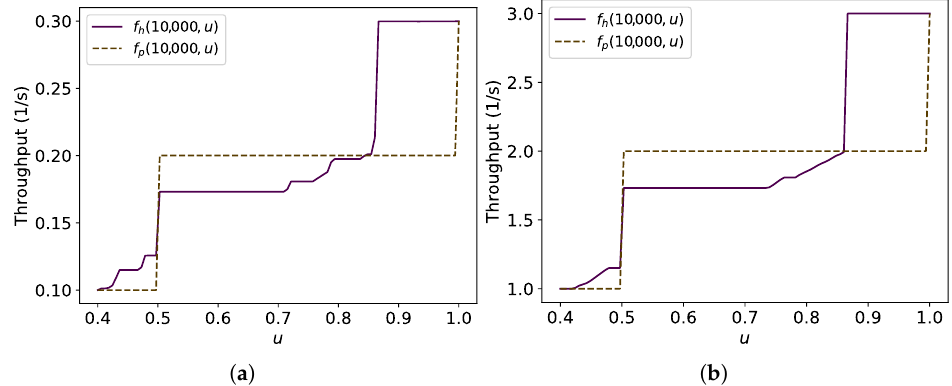
Figure 17. Comparison of f p and f h for u ∈ [0.4,1], T = 10,000 s, v ∈ { 0.1,1 } m/s and d = 1 m. The difference in the lines of f h is due to θ ∗ being different for each value of v . ( a ) v = 0.1 m/s; ( b ) v = 1